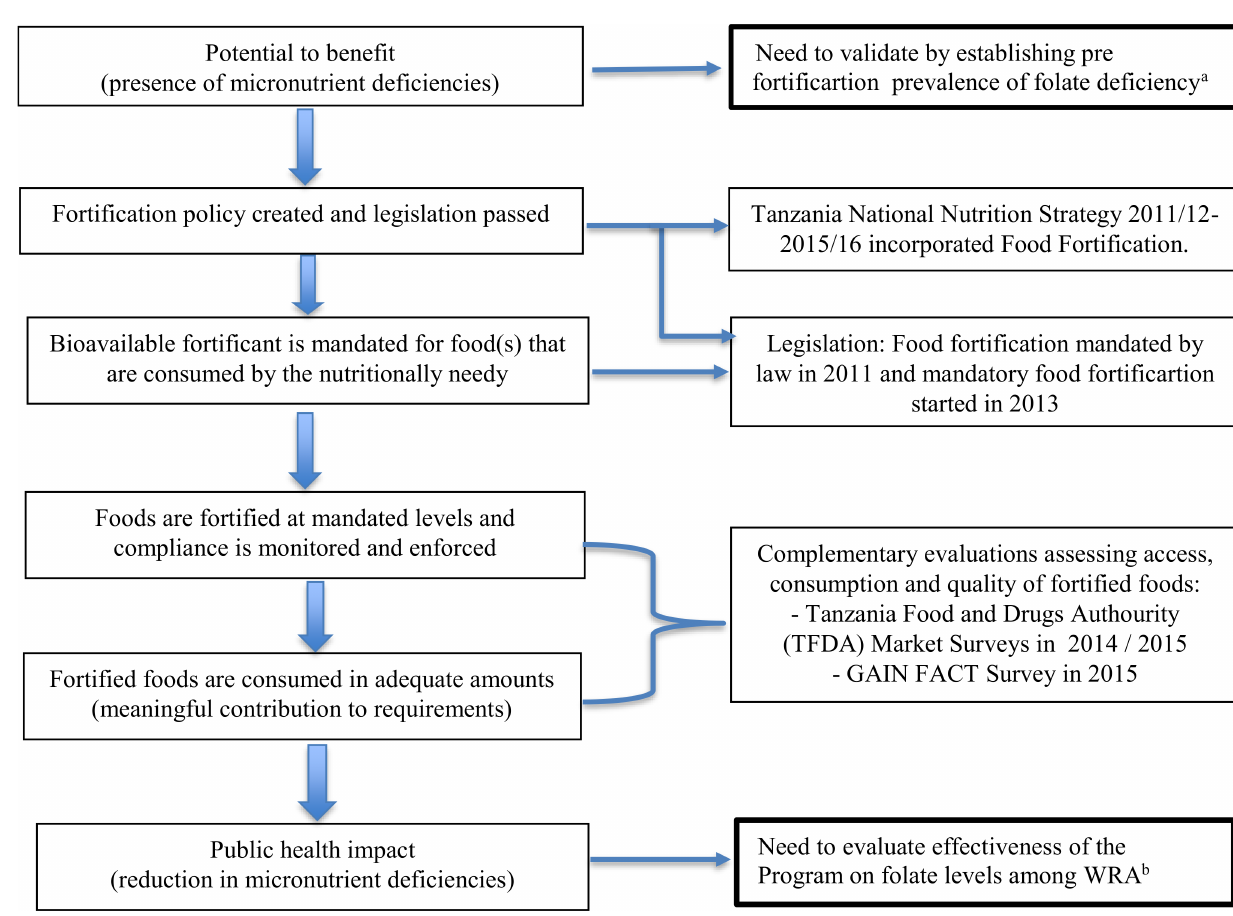
Fig 1. Program Impact Pathway (PIP) for large-scale food fortification programs. Adopted with modifications from ReynaldoMartorell et al. Am J Clin Nutr 2015; 101:210–217. a,b Areas of focus for this evaluation in the context of TanzaniaNationalFood Fortification program.